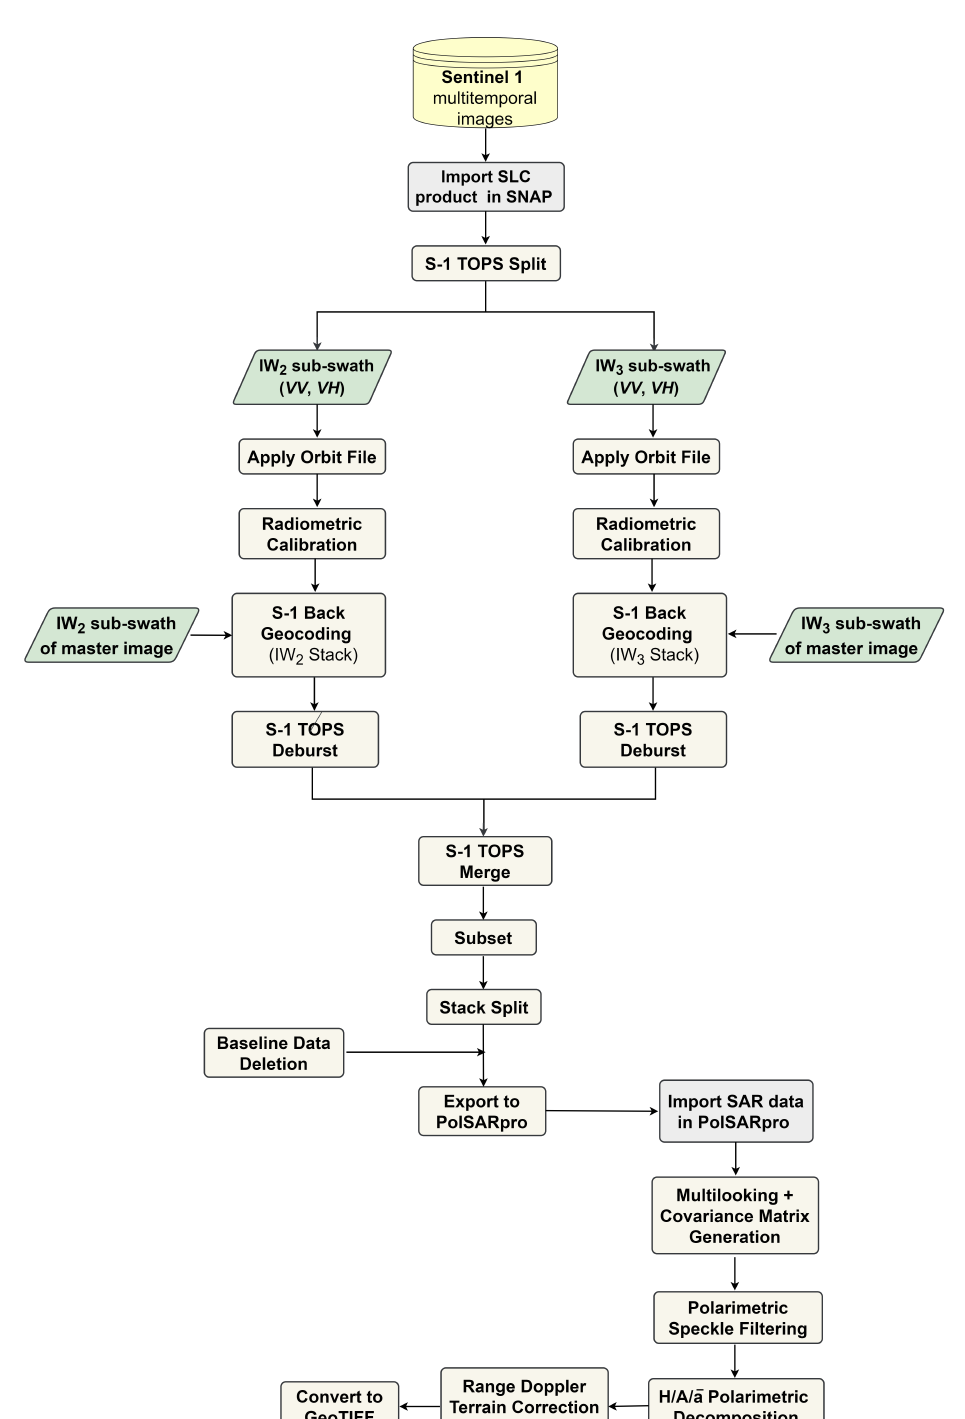
Figure 3. Flowchart of Sentinel-1 data pre-processing. Apart from using the original Sentinel-2 bands, we evaluated the potential of four vege- tation indices, namely the Normalized Difference Vegetation index (NDVI), the Normalized Difference Water Index (NDWI), the Plant Senescence Reflectance Index (PSRI), and the Soil Adjusted Vegetation Index (SAVI), in categorizing the different types of crops of the agricultural study area (Equations (14)–(17)). Vegetation indices are calculated via simple mathematical formulas, by using information of targets’ spectral responses at different wavelength intervals [106] and provide valuable, additional information about